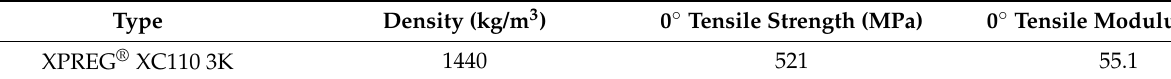
Table 5. Mechanical properties of XPREG ® XC110 (3K) prepreg system.